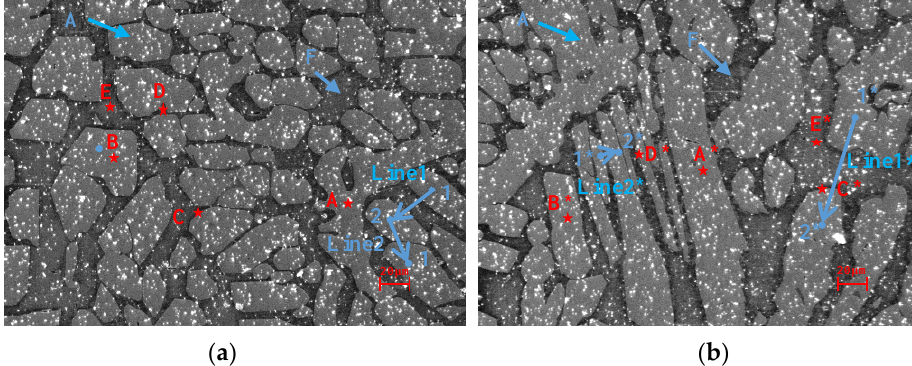
Figure 1. Schematic drawing of the specimen for tensile test.